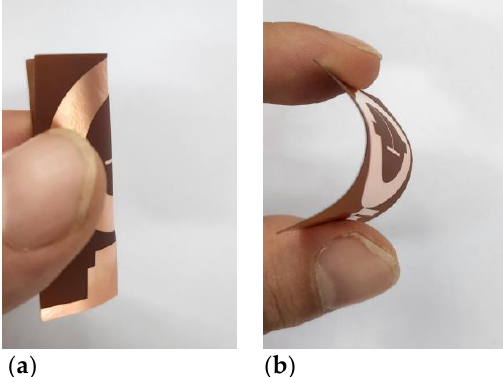
Figure 15. Photo of the antenna when bent. ( a ) Antenna bent horizontally; ( b ) antenna bent vertically.